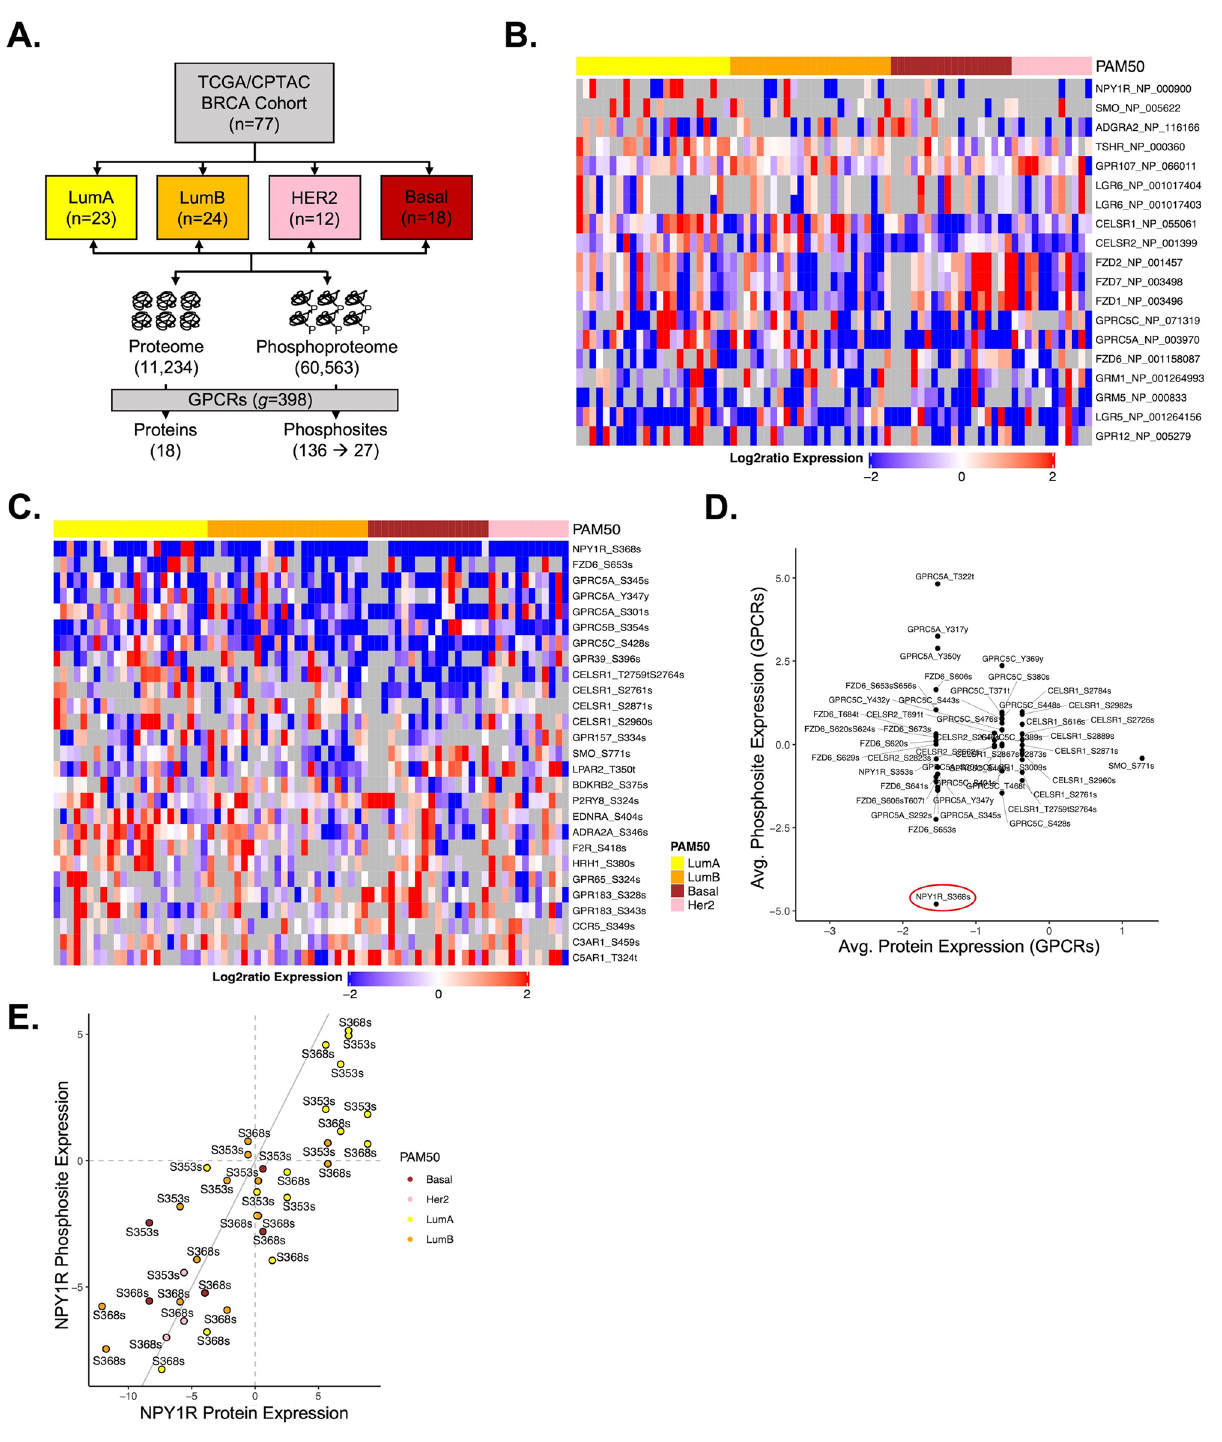
Figure 1. GPCR proteomic and phosphoproteomic analysis identified NPY1R as a potential GPCR target in luminal BC. ( A ) NCI-CPTAC breast cohort of 77 patients consisting of 23 LumA, 24 LumB, 12 HER2 and 18 basal-like tumors. The mass spectrometry based iTRAQ method identified a total 11,234 proteins and 60,563 phosphosites in 77 samples of which 18 proteins and 136 sites (27 sites with less than 50% missing value) overlapped with GPCRs. ( B ) The 18 proteins that were quantified: NPY1R, SMO, ADGRA2, TSHR, GPR107, LGR5, LGR6, CELSR1, CELSR2, FZD1, FZD2, FZD6, FZD7, GPRC5A, GPRC5C, GRM1, GRM5, and GPR12. ( C ) The 27 phosphosites corresponding to 21 proteins were NPY1R, FZD6, GPRC5A, GPRC5B, GPRC5C, GPR39, GPR65, GPR157, GPR183, CELSR1, SMO, LPAR2, BDKRB2, P2RY8, EDNRA, ADRA2A, F2R, HRH1, CCR5, C3AR1, and C5AR1. ( D ) Average NPY1R protein and phosphosite expression showed hypophosphorylation at S368s in overall samples but ( E ) hyperphosphorylation in lumA subtype. The expression values ranging from -2 to 2 (blue to red) indicate aggregated iTRAQ log-ratios for each sample, which are normalized by subtracting the mean of all values. Each row represents an individual GPCR and each column is a patient